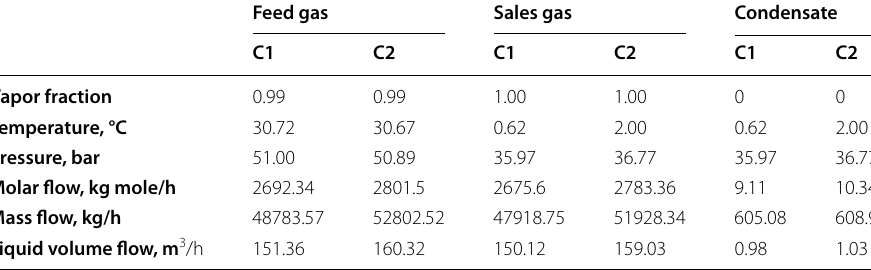
Table 5 Conditions of low temperature separator train unit Feed gas Sales gas